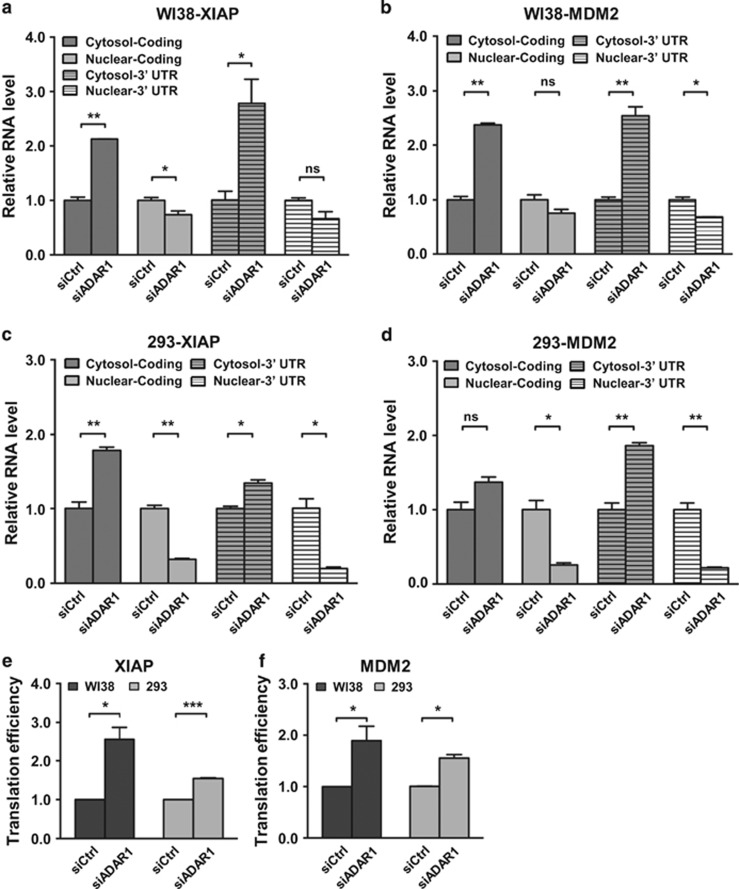
ADAR1 alters the nucleocytoplasmic transport of the XIAP and MDM2 transcripts. (a–d) Control (siCtrl) and ADAR1 knockdown (siADAR1) WI38 (a and b) and 293 (c and d) cells were separated into nuclear and cytosolic fractions. Bar graphs show relative distribution of the indicated target transcripts (XIAP in a and c, MDM2 in b and d) between the nuclear and cytosolic compartments, as assessed by real-time RT-PCR. Relative expression levels were normalized to the control group. Means±S.D. were calculated from three independent experiments (NS, not significant or P>0.05; *P<0.05; **P<0.01; ***P<0.001). (e and f) mRNA translation rate was measured by analyzing target RNA association with ribosome nascent-chains complex (RNC) (see Materials and methods). Relative RNA expression (XIAP in e and MDM2 in f) was determined by real-time RT-PCR (GAPDH as the internal control), and normalized to the levels of control group. Data are presented as means±S.D.